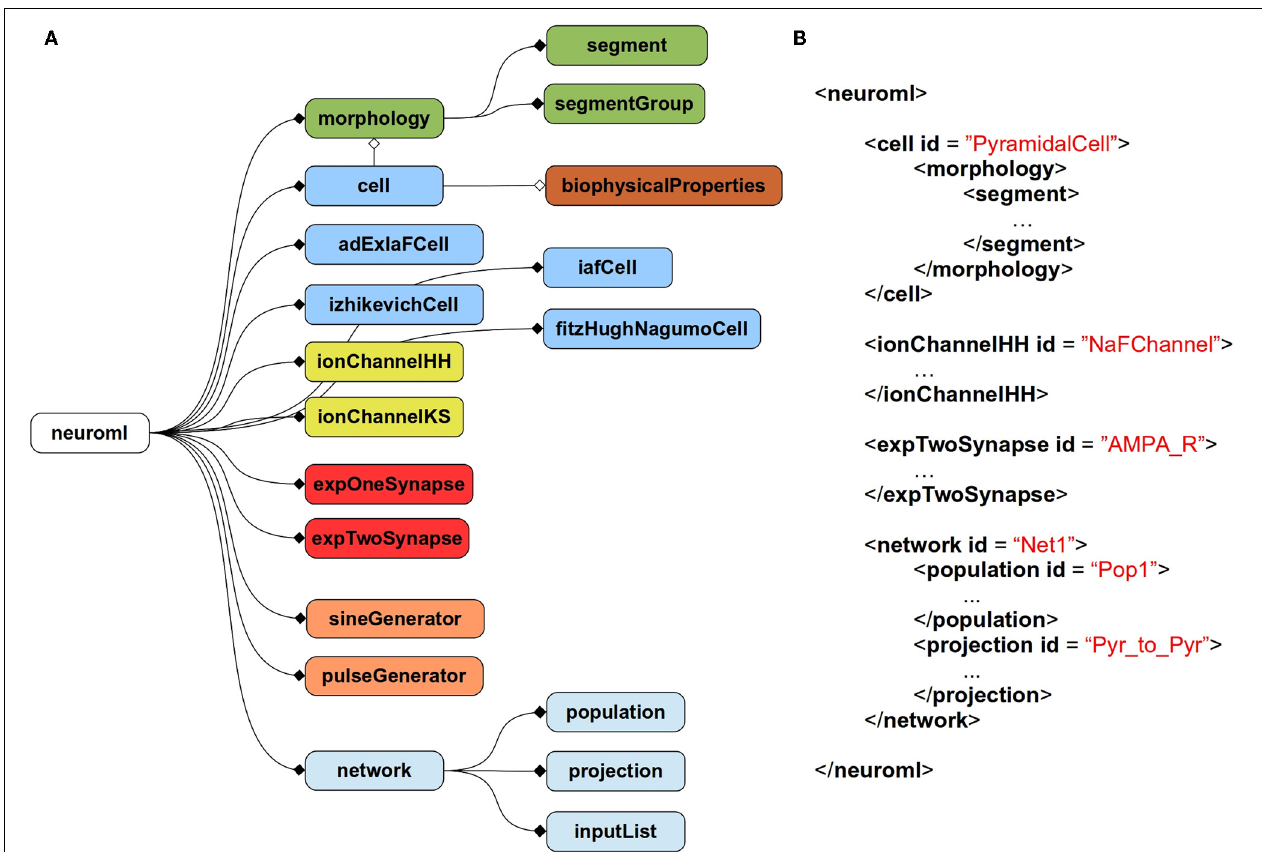
FIGURE 1 | Structure of NeuroML v2. (A) Overall structure of NeuroML v2. The top-level element of NeuroML, neuroml , contains a number of child elements of various types. A morphology element contains lists of segment and segmentGroup elements defining the structure of the neuronal morphology. Various cell types are allowed including point neurons such as izhikevichCell , but also cell elements which can have detailed morphologies and biophysicalProperties for ion channel densities etc. Ion channels of two main types can be specified, based on either the Hodgkin-Huxley formalism or using a kinetic scheme-based description. Allowed synapse models include single and double exponential conductance waveform models. Current inputs